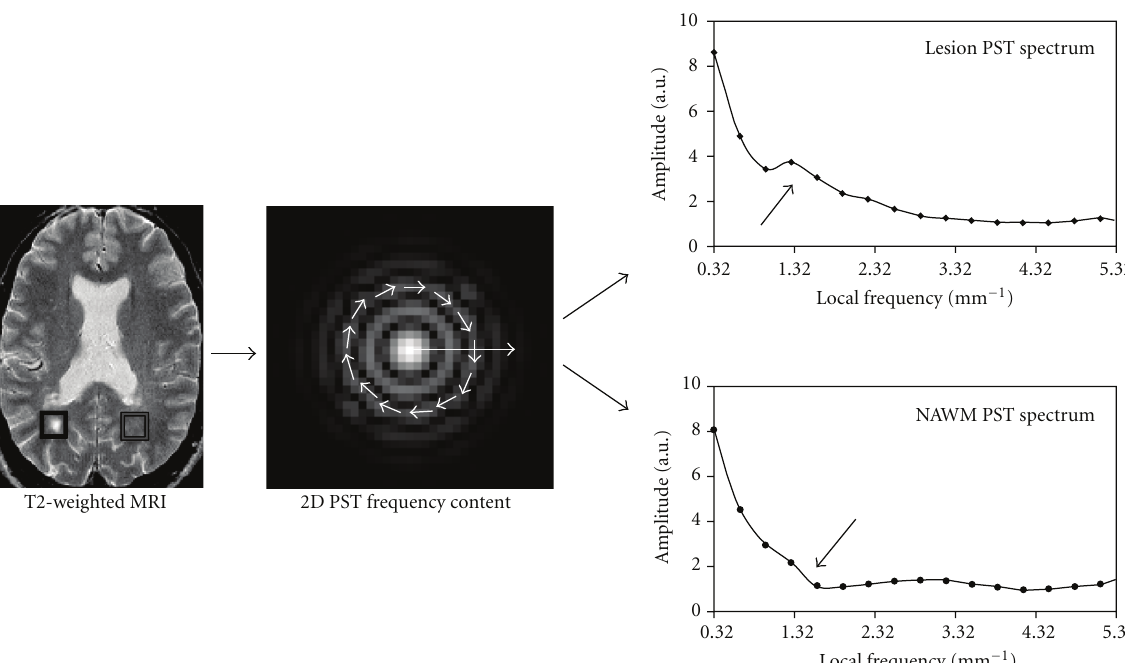
Figure 3: Texture analysis of the same image demonstrated in Figure 2 using a spectral method (polar Stockwell transform, PST). The PST spectra were first calculated as radius and orientation in polar coordinate (middle figure with arrows in circle); then a 1-dimentional spectrum (texture curve) was obtained by integrating frequencies along the radial direction for each frequency and pixel. Plots in the right side of the figure demonstrate the average texture curve of central 5 × 5 pixels in the lesion (right box) and the contralateral NAWM of the patient. Note that the amplitude of the low-frequency range appears greater (coarser) in the lesion than in the NAWM